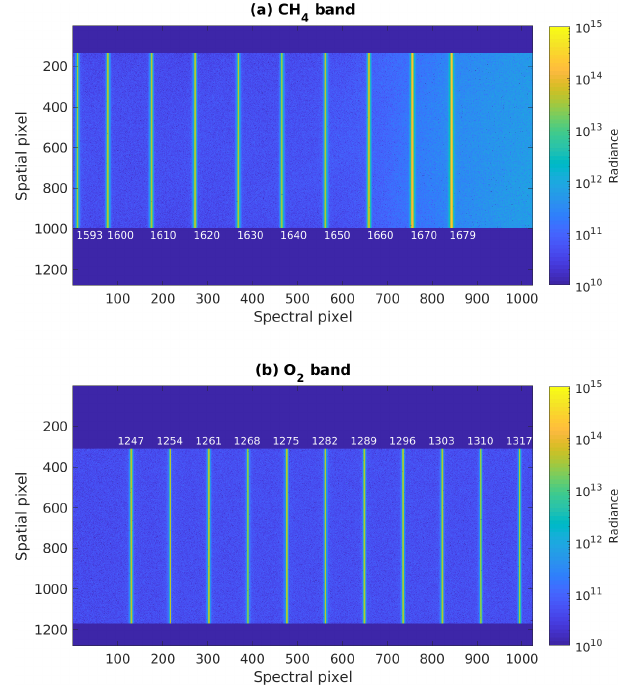
Figure 2. Responses of the focal plane arrays shown as cali- brated radiance for the CH 4 (a) and O 2 band (b) over a range of laser wavelengths. The laser wavelengths in nanometers are la- beled next to the corresponding slit images. The radiance is in pho- tonss − 1 cm − 2 nm − 1 sr − 1